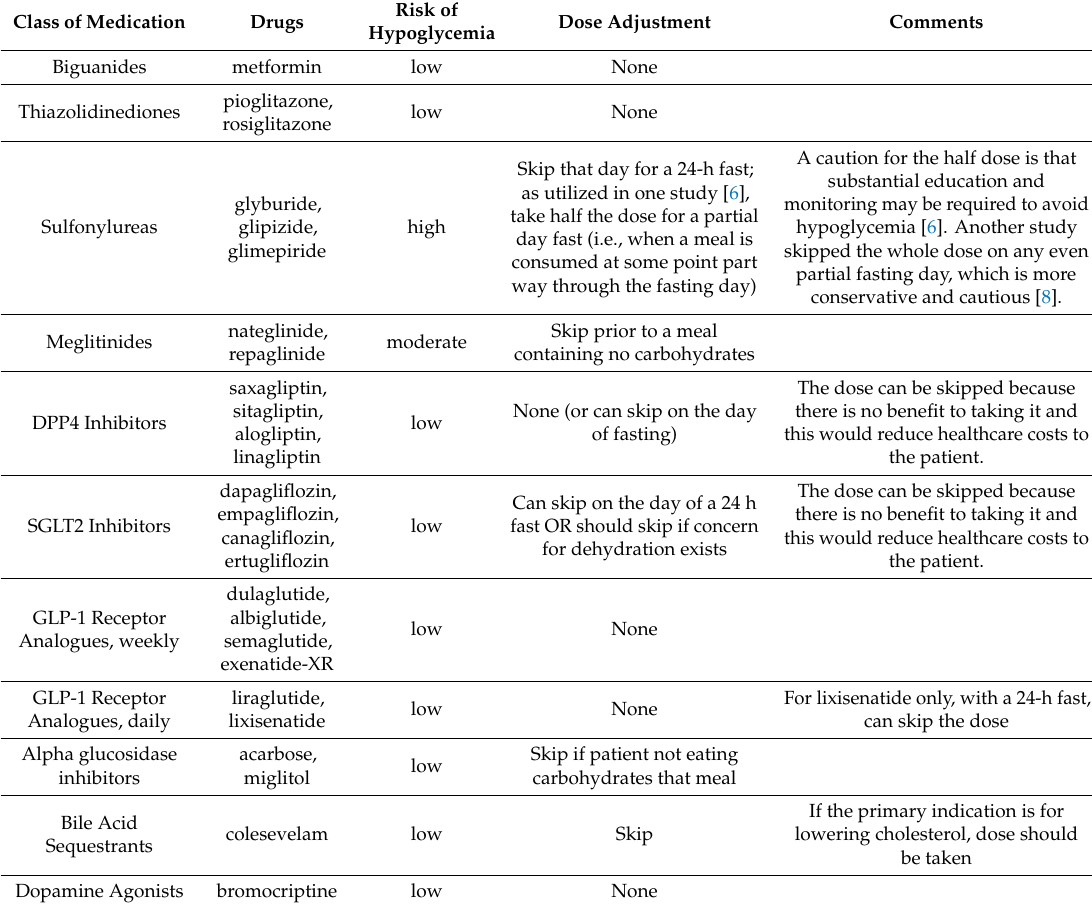
Table 2. Considerations and recommendations for adjustment of antidiabetic medications during intermittent